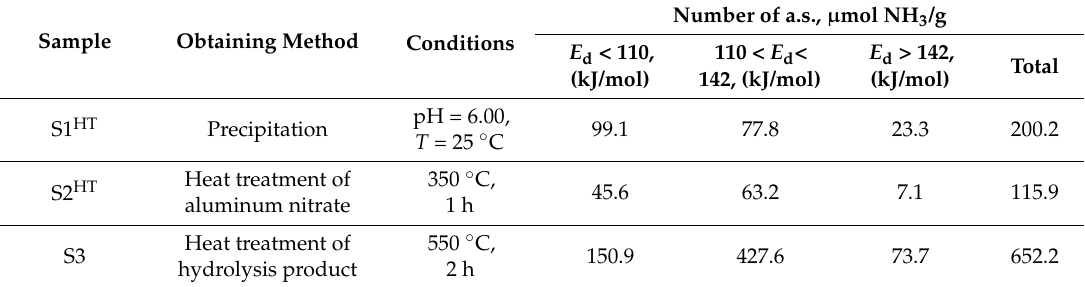
Table 5. Ammonia (NH 3 ) TPD acid characteristics of samples S1 HT , S2 HT , and S3.